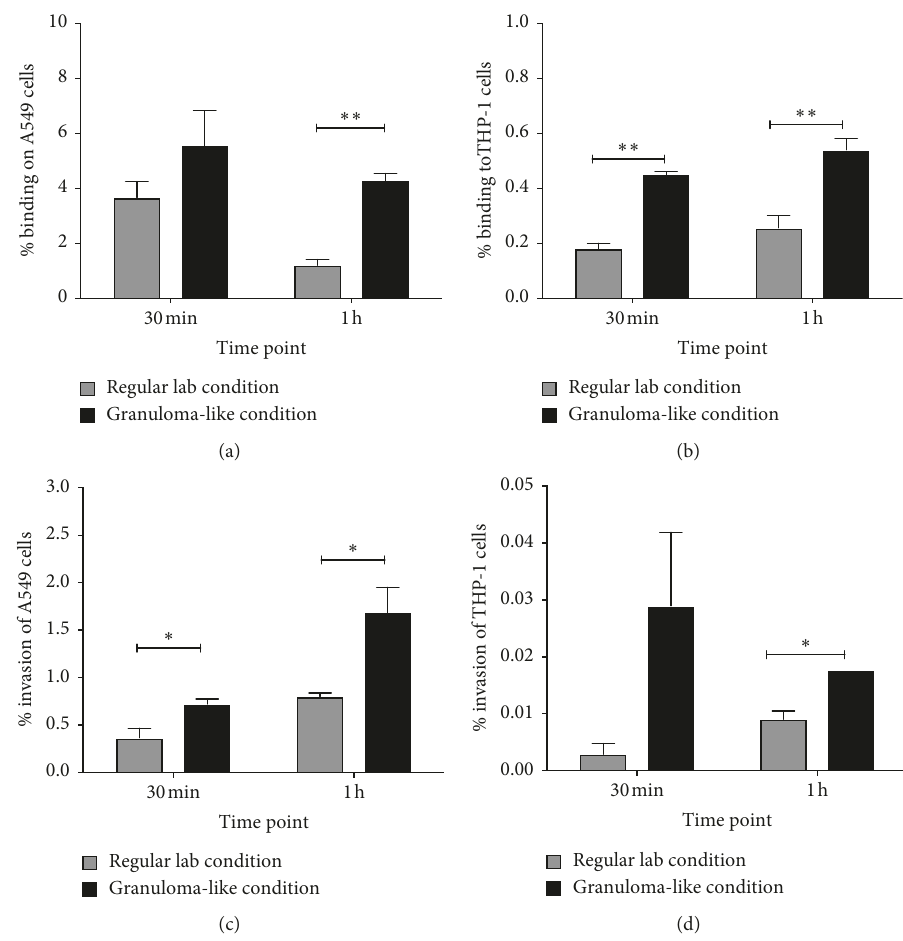
F IGURE 1: Binding and invasion assays of M. bovis BCG exposed to granuloma-like (pH 6.0, 0.3 M dextrose, anaerobic) and regular lab (pH 7.2, 20% O 2 ) conditions. (a) Percentage of bacterial binding to A549 lung epithelial cells. (b) Percentage of bacterial binding to THP-1 macrophages. (c) Percentage of bacterial invasion of A549 cells. (d) Percentage of bacterial invasion of THP-1 cells. Results represent